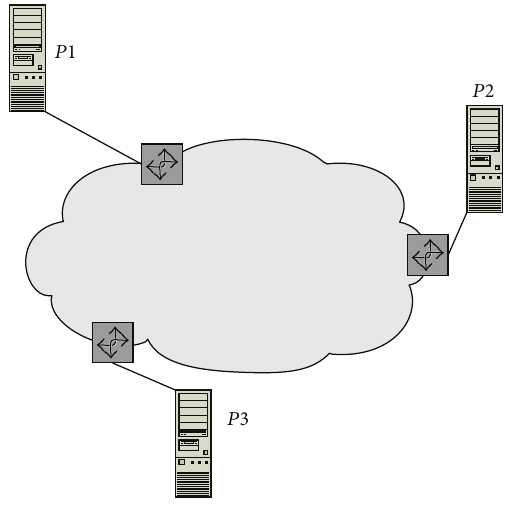
Figure 5: Network topology for DAG example.